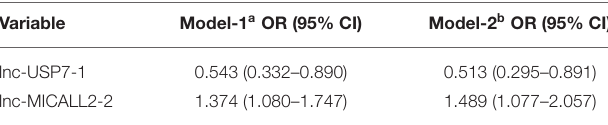
TABLE 2 | Multivariable logistic regression analyses for the association between lncRNAs and CHD.